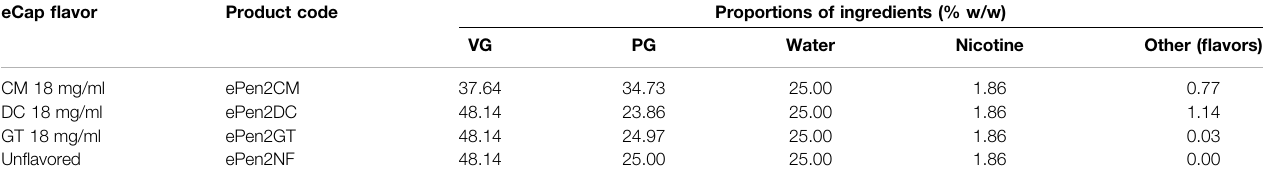
TABLE 1 | Speci fi ed composition of the e-liquids used in this study. eCap fl